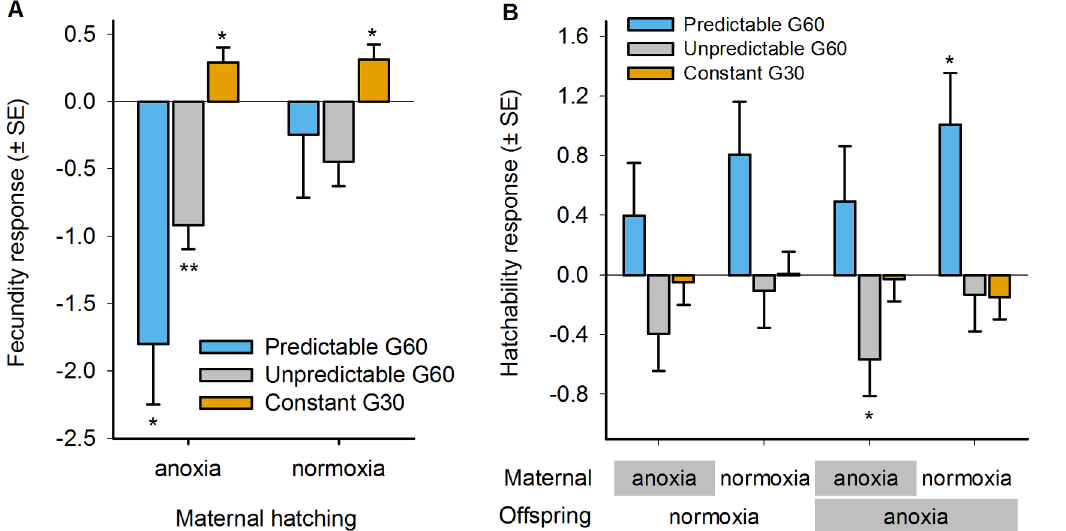
Fig 5. Evolution of maternal effects. Fecundity (A) and hatchability (B) in the predictable (blue) and unpredictable (grey) populations at generation 60, and in the constant populations at generation 30 (orange), relative to the ancestral population (zero line). Note that, as for fitness, evolutionary responses are measured as the natural logarithm of evolved trait values over the ancestral mean trait value per block (see Materials and Methods). Mean and error least square estimates are shown after separate LMM for each experimental regime, taking replicate population as a random factor and maternal hatching (A) or maternal – offspring hatching treatment (B) as fixed factors. Significant evolutionary responses (post-hoc Student t tests, with LMM-corrected KR degrees of freedom) are shown above each bar: * p < 0.05; ** p < 0.01. Data deposited in the Dryad repository: http://dx.doi.org/10.5061/dryad.56bb4 [59].